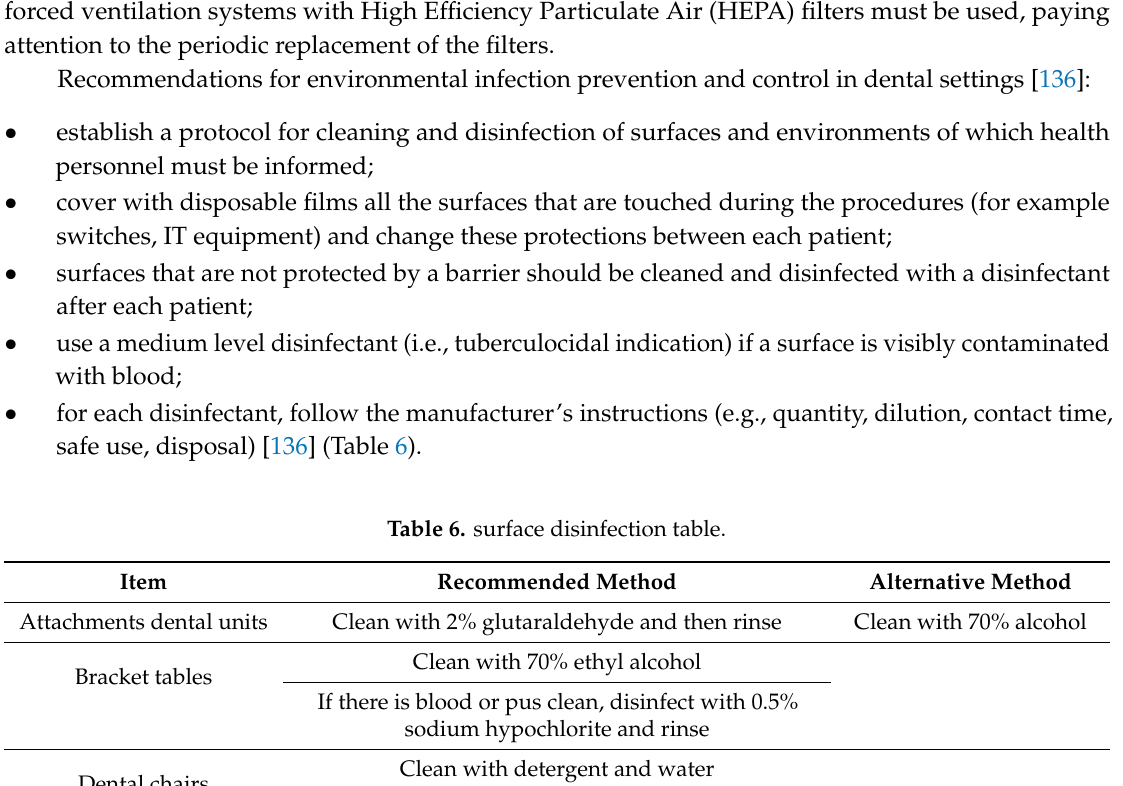
Table modified from DH ICCo. Guidelines on Infection Control in Dental Clinics 1993